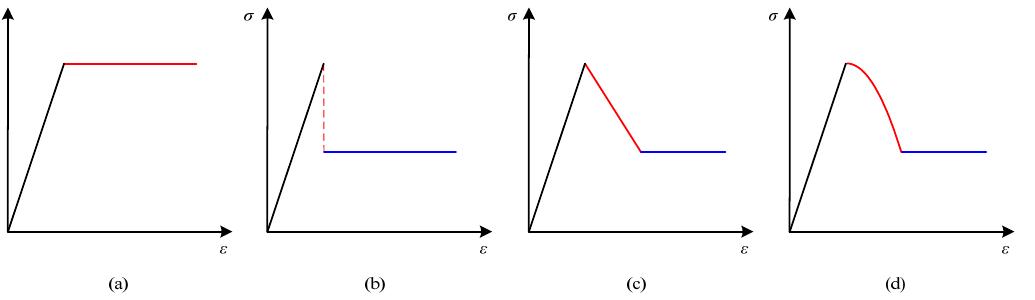
Figure 1. Different constitutive models. ( a ) elastic–perfectly plastic; ( b ) elastic–brittle-plastic; ( c ) linear strain-softening; ( d ) nonlinear strain-softening.